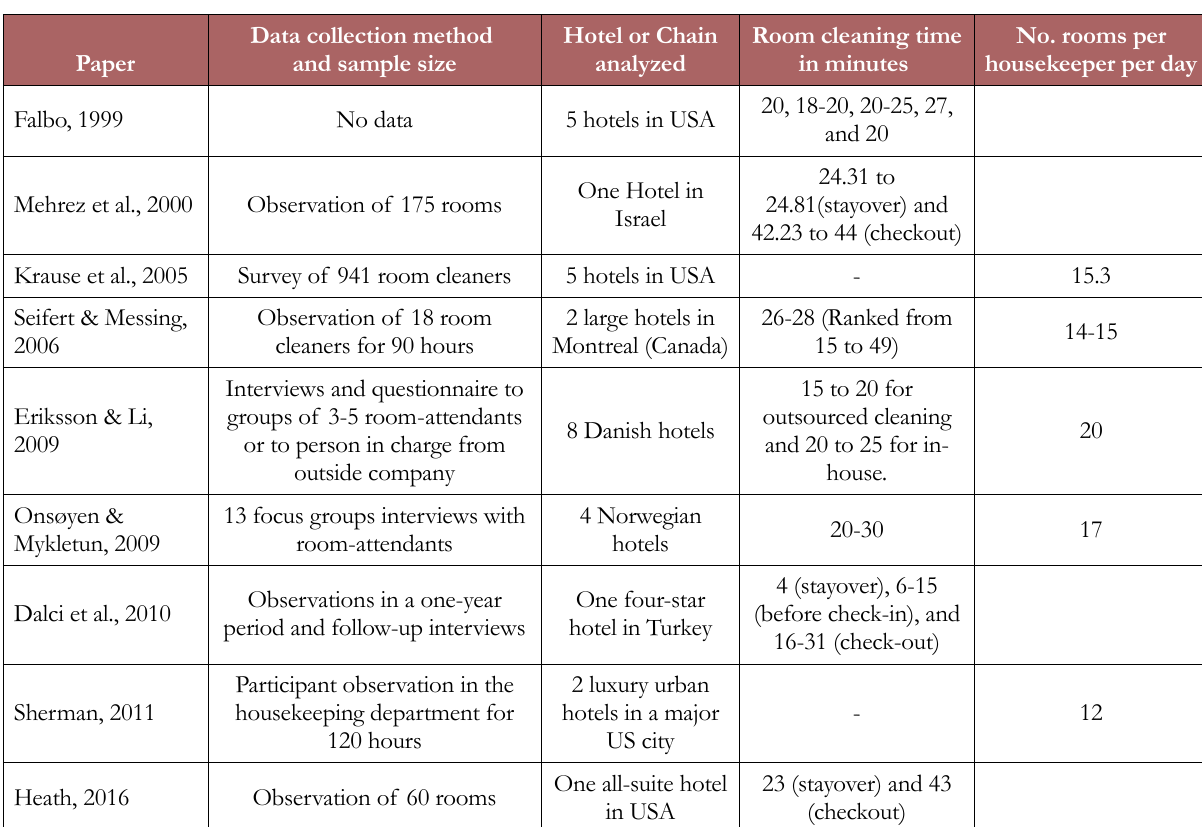
Table 1. Room cleaning times collected in previous